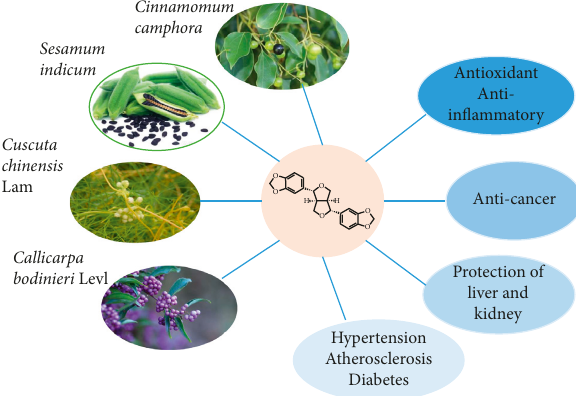
Figure 1: Main plant sources and pharmacological activities of sesamin.